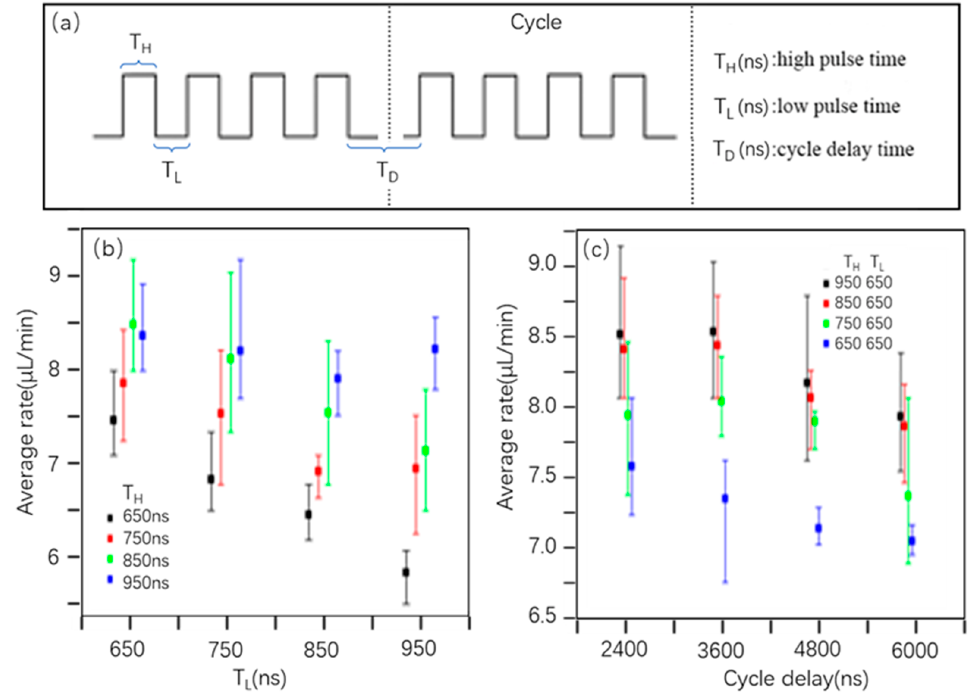
Figure 2. ( a ) The driving waveform imposed on the heater. ( b ) The relationship between average flow rate and low pulse time (T L ), high pulse time (T H ). ( c ) The effect of cycle delay time (T D ) on the flow rate.